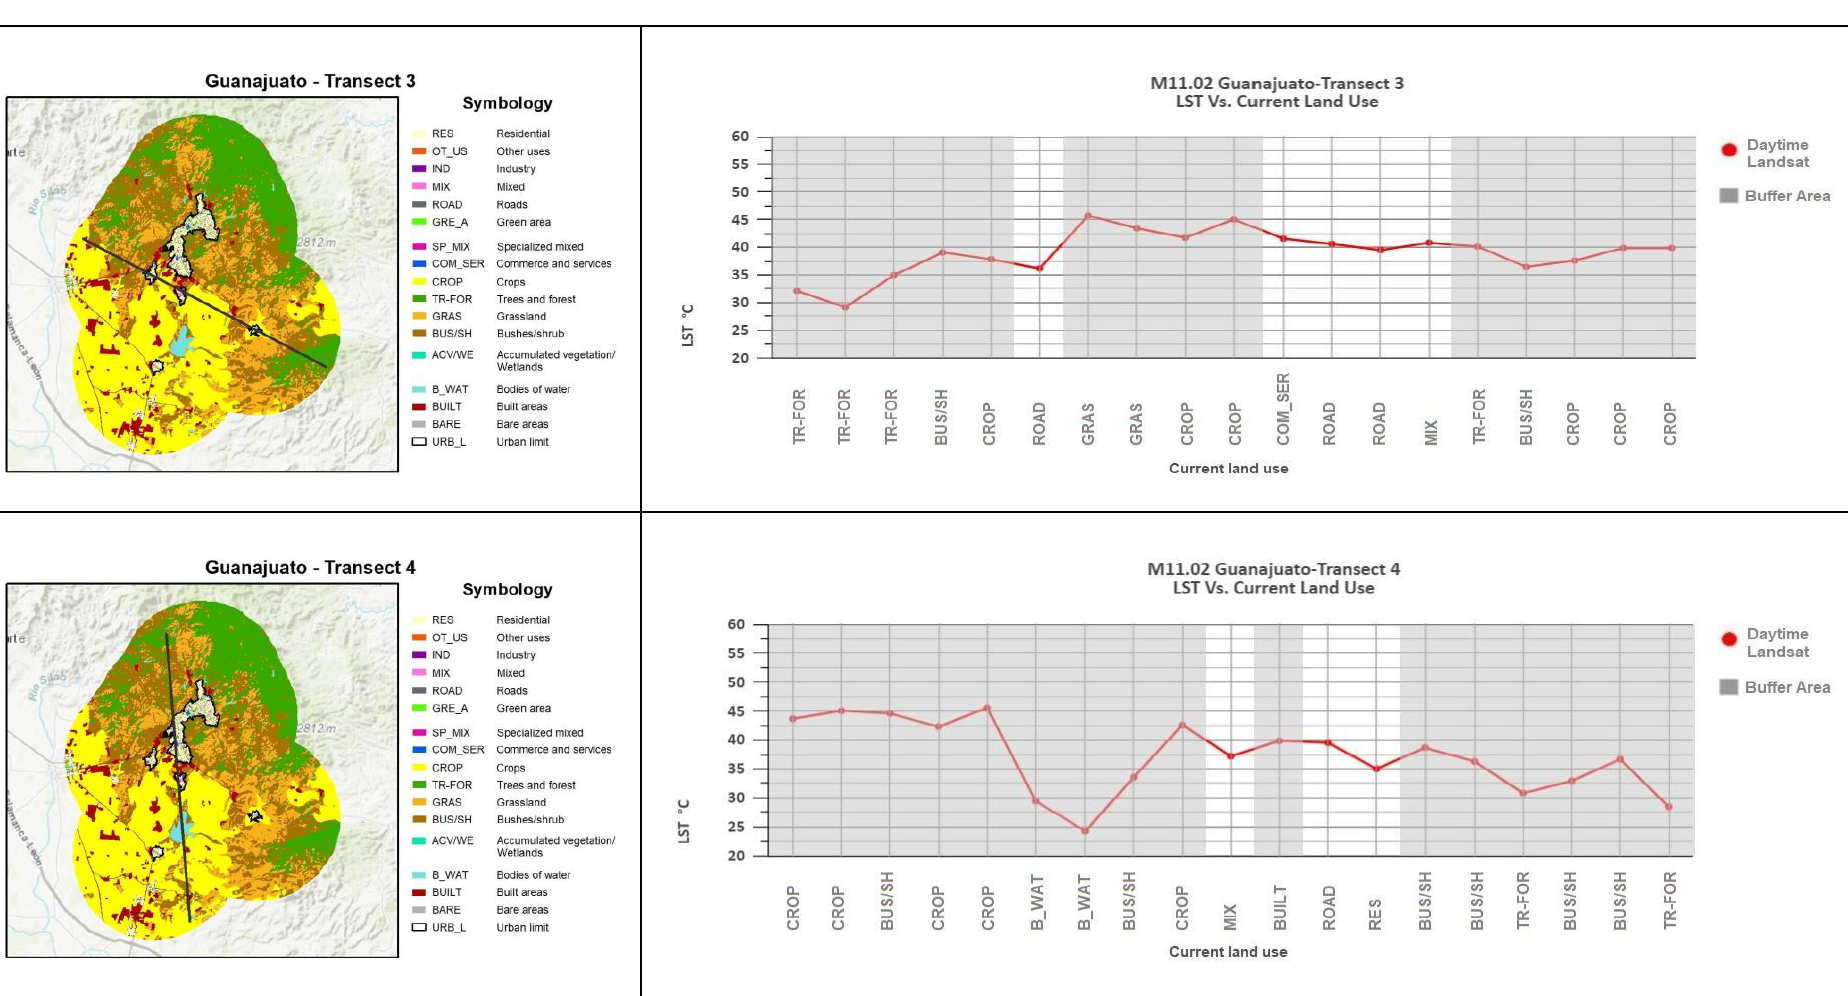
Figure 7. Transects of Guanajuato metropolitan city.